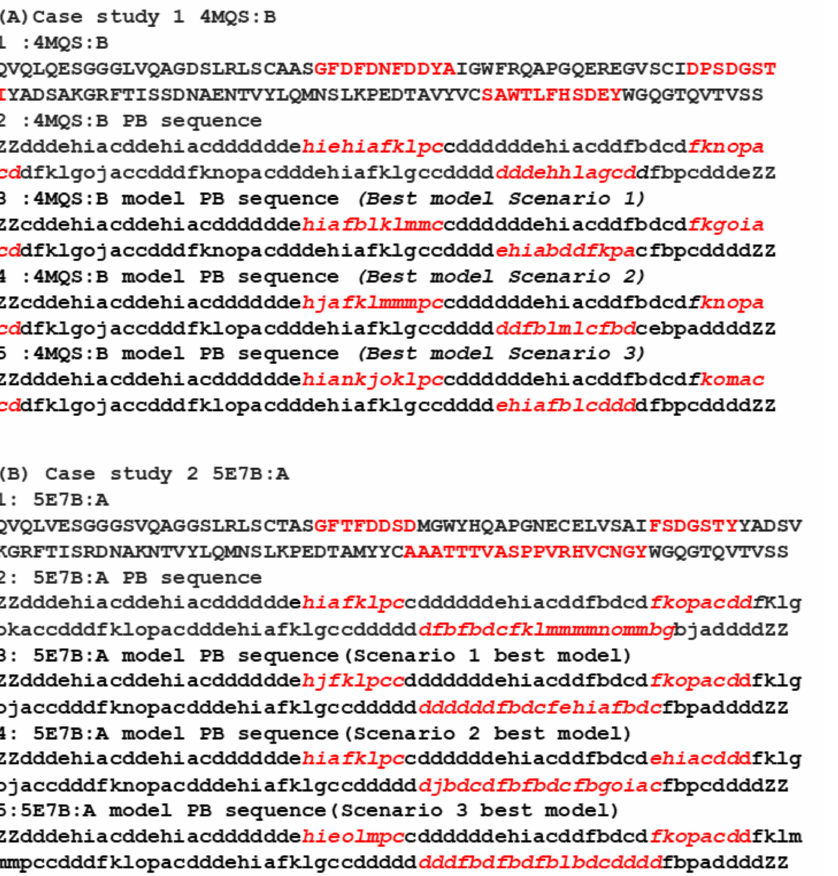
Figure A9. Amino acid and PB sequences of two V H Hs (PDB IDs 4MQS:B and 5E7B:A). ( A ) In case study 1; 1: PDB ID 4MQS:B amino acid sequence; 2: PB sequence of PDB ID 4MQS:B crystal structure, 3, 4, and 5 PB sequences of models from bestSeqIdTemp , bestStructTemp, and 3bestSeqIdTemp scenarios. ( B ) In case study 2; 1: PDB ID 5E7B:A amino acid sequence, 2: PB sequence of PDB ID 5E7B crystal structure, 3, 4, and 5 are PB sequences of models from bestSeqIdTemp , bestStructTemp, and 3bestSeqIdTemp scenarios. The highlighted regions in red are the